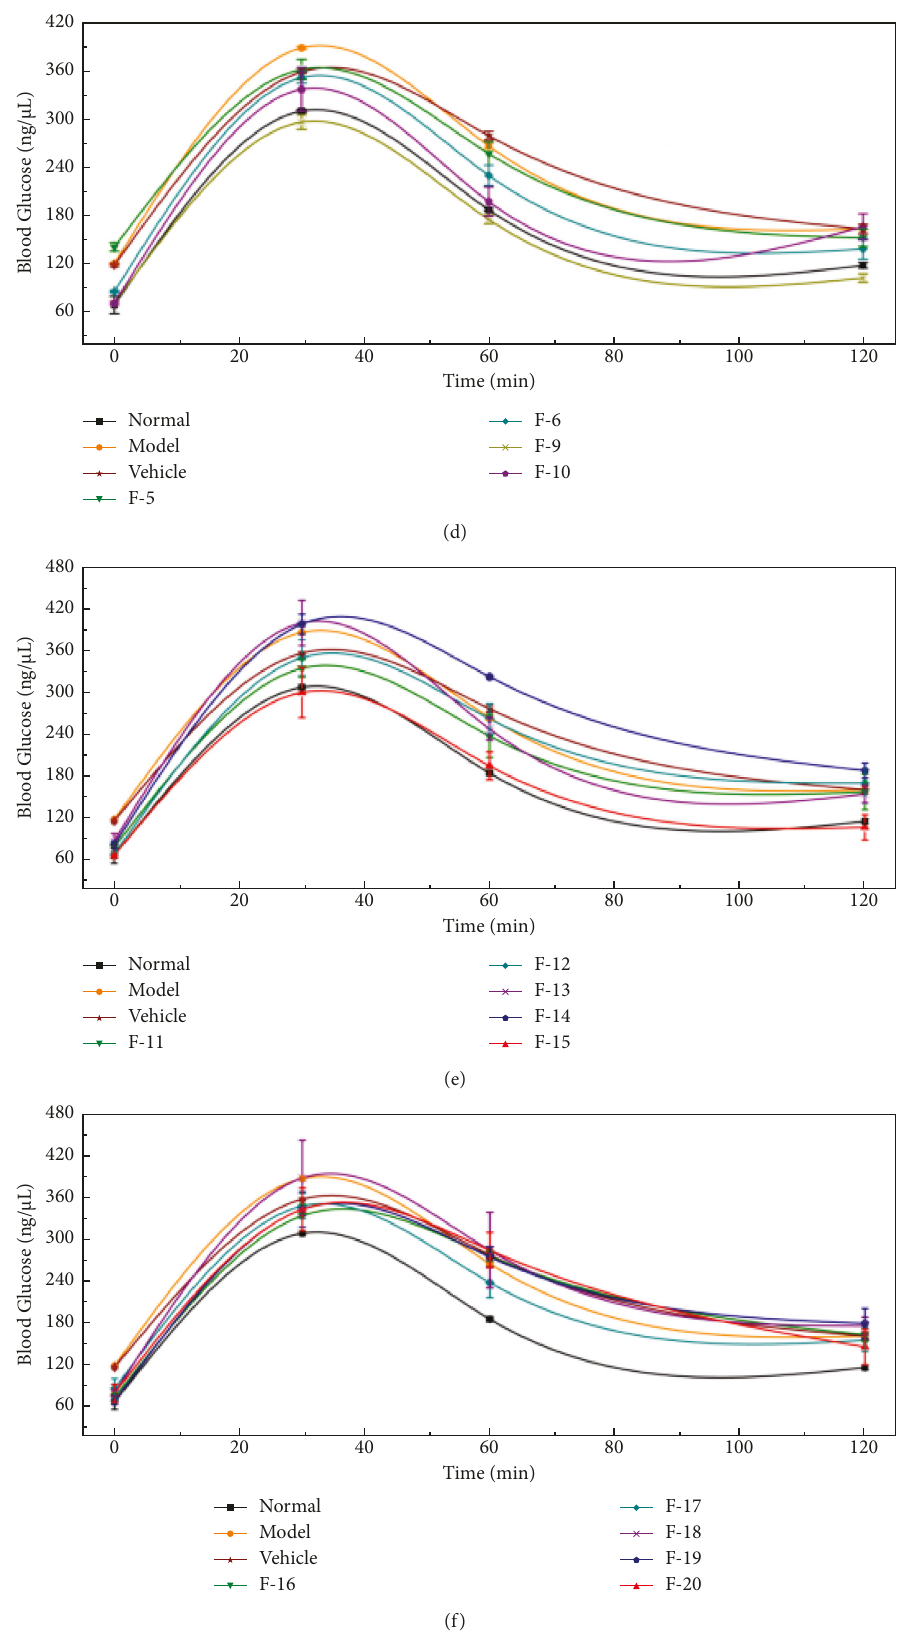
Figure 1: Preliminary efficacy test. (a, b) Bodyweight and Blood glucose changes in mice. (c–f) Intraperitoneal glucose tolerance test (IGTT)